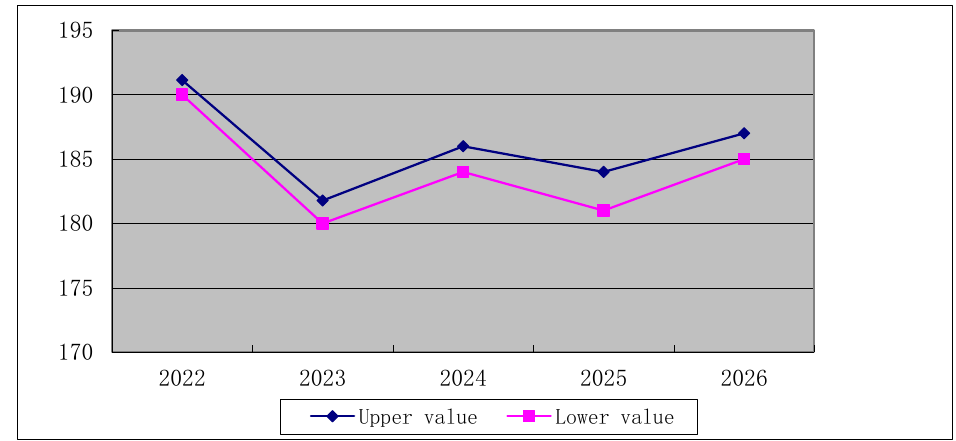
Figure 20. The variation interval of water requirement with the influence of the tertiary industry in Inner Mongolia.